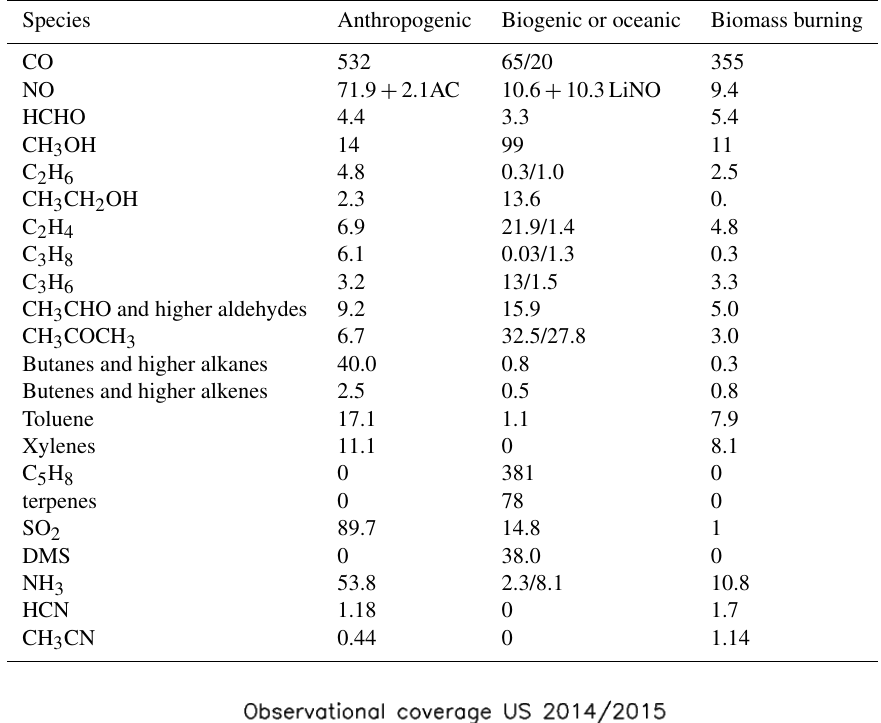
Table 4. Global annual mean emissions for 2014 as adopted in current IFS(CBA) model simulations [Tg speciesyr − 1 ]. No direct emissions of HONO are included. For NO, the aircraft (AC) and lightning NO x (LiNO) emissions are also given as anthropogenic and biogenic contributions, respectively.